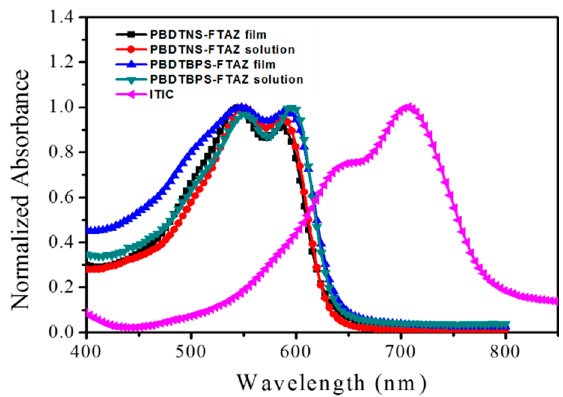
Figure 1. Normalized absorption spectra of PBDTNS-FTAZ, PBDTBPS-FTAZ in o -DCB solution and the films of PBDTNS-FTAZ, PBDTBPS-FTAZ and ITIC.